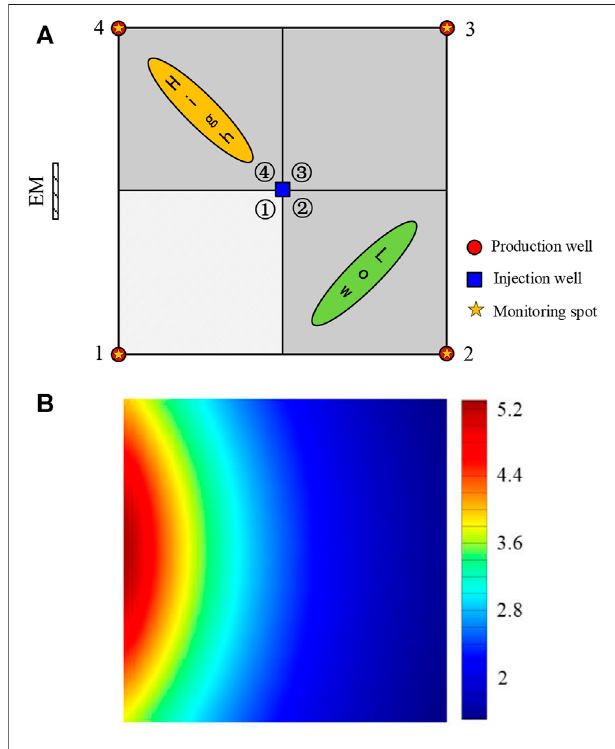
FIGURE 6 | A fi ve-spot heterogeneous reservoir model. (A) Model geometry; (B) Distribution of background magnetic fl ux density norm log 10 |B| in units of